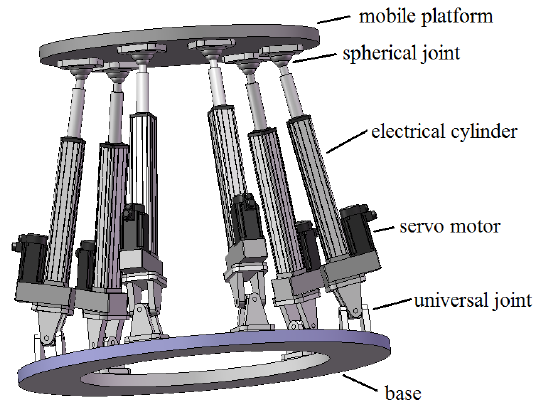
Figure 2. Schematic diagram of the Stewart platform.